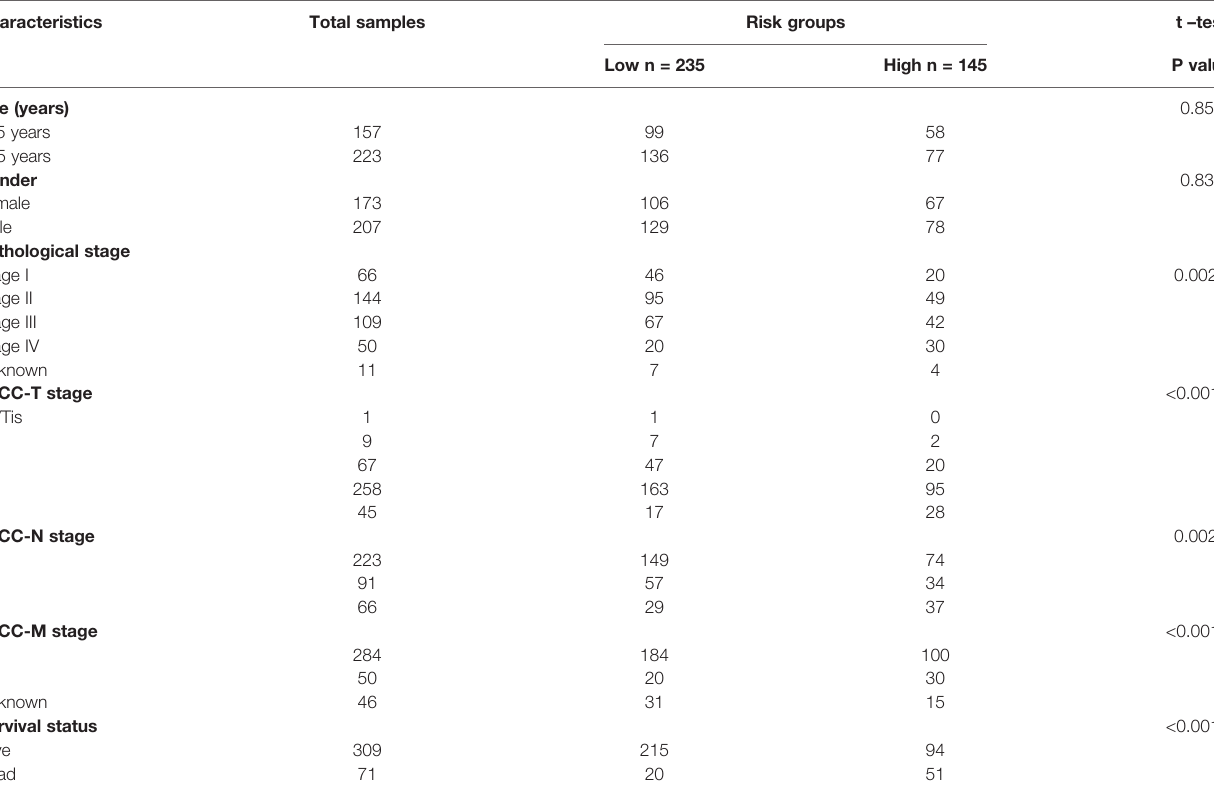
TABLE 1 | The clinical characteristics of COAD